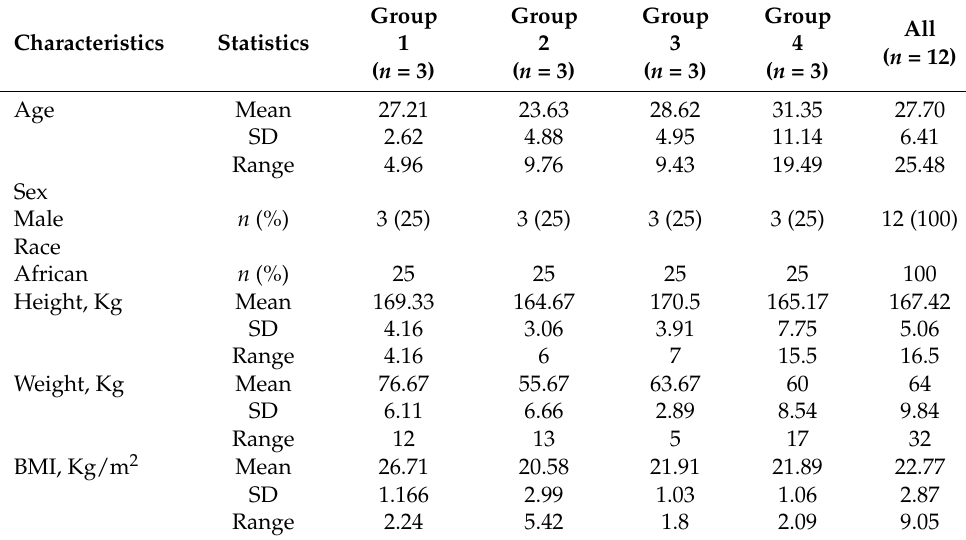
Table 2. Summary of demographic characteristics of each study group.